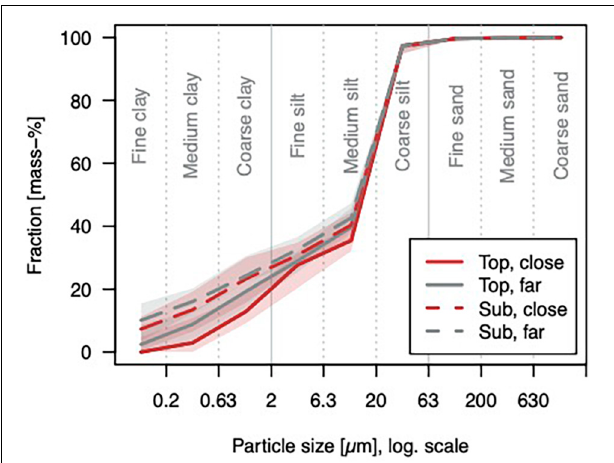
FIGURE 5 | Grain size distribution curves: Medians and quartiles for the topsoil (5–10 cm depth, “top”) and the subsoil (25–30 cm depth, “sub”) close to trees ( < 1 m distance to a stem, “close”) or further from trees ( > 1 m distance to a stem, “far”), n in order of appearance: 18, 25, 27, and 28. The clay fraction is significantly different for tree-close and -far in the topsoil ( p = 0.03).